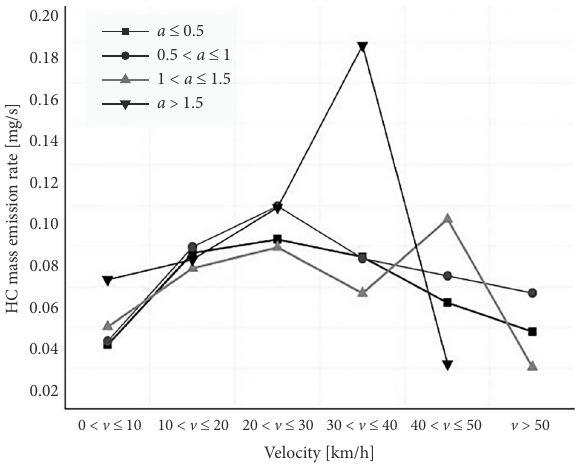
Figure 7. Effect of both velocity and acceleration on the mass emission rate of